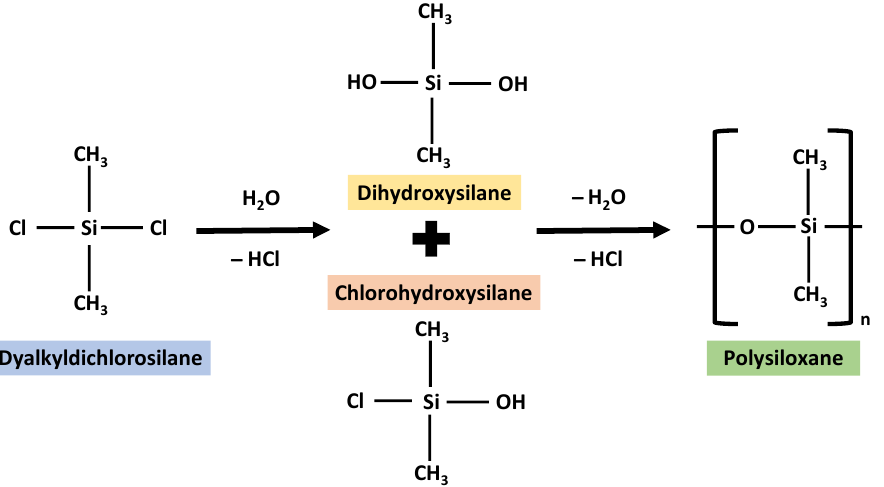
Figure 2. The synthesis of silicone redrawn and adopted with some modifications in reference from the image from Odian, G. (2004) [13].